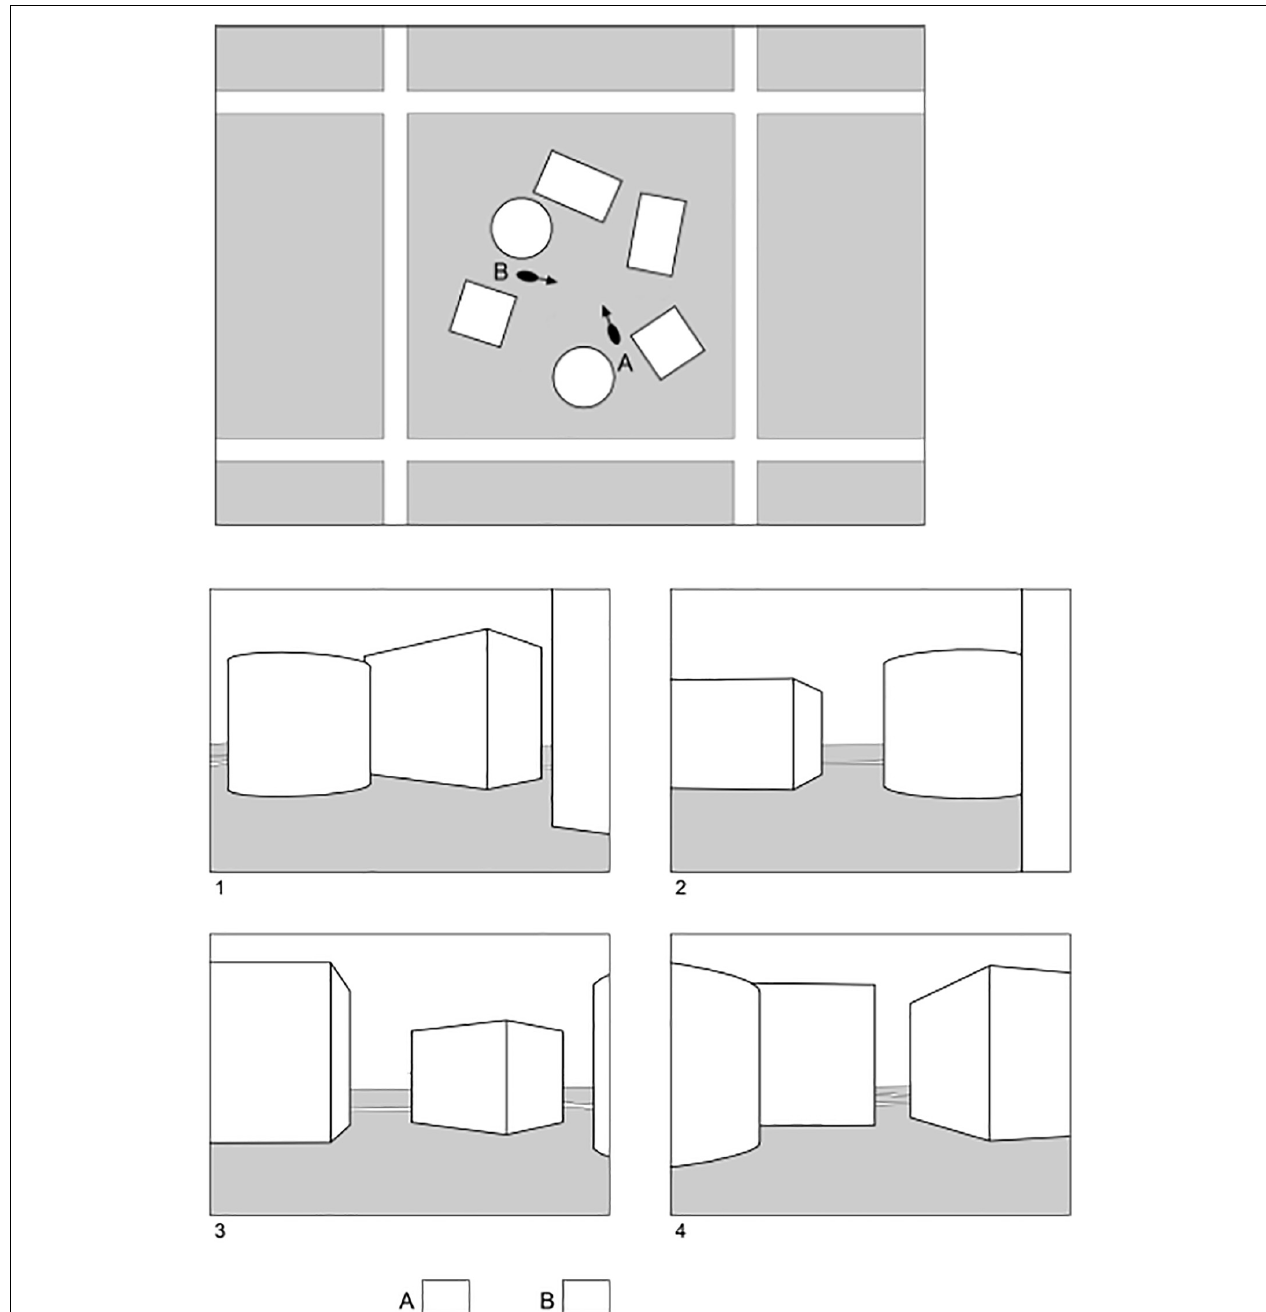
FIGURE 1 | Example of an item on the Urban Layout